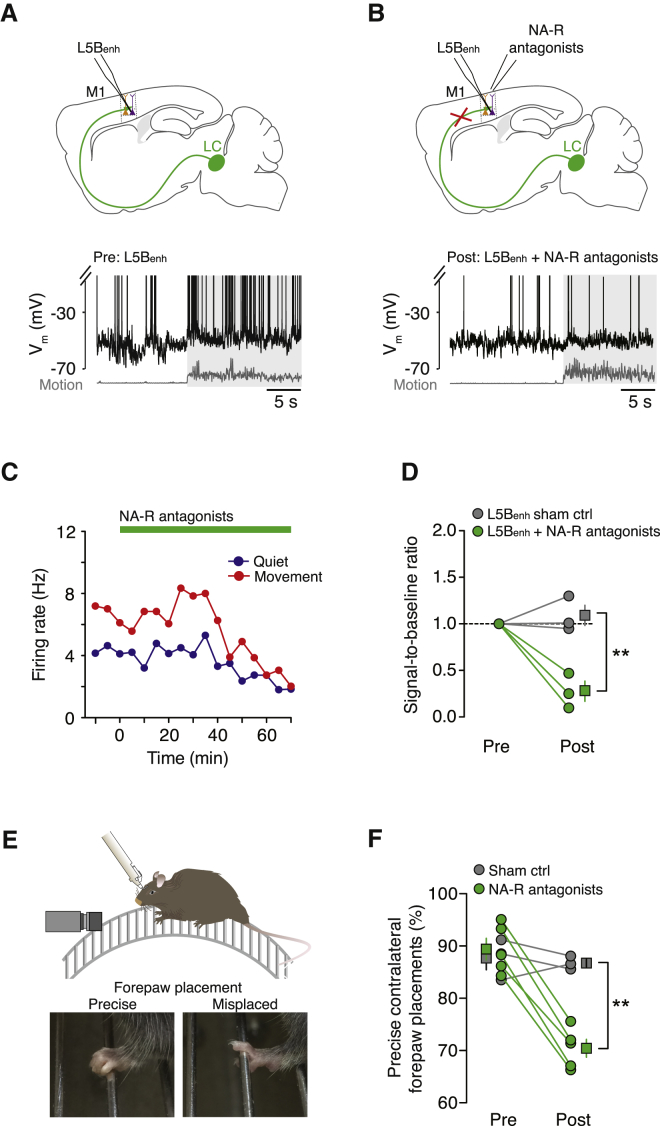
Blocking Noradrenergic Input Reduces the SBR in L5Benh Neurons and Impairs Contralateral Forepaw Motor Coordination(A and B) Schematic representation of the experimental design and representative voltage traces from an L5Benh pyramidal neuron prior to (A) and after (B, >30 min) topical application of noradrenergic receptor antagonists. Gray shading depicts movement.(C) Time course shows quiet (blue) and movement-related (red) firing rates in an L5Benh pyramidal neuron before and after noradrenergic receptor blockade (green bar).(D) Movement-induced SBR in L5Benh pyramidal neurons before and >30 min after application of noradrenergic receptor antagonists (green circles, n = 3) or saline (gray circles, n = 3). Square symbols represent mean ± SEM. Unpaired t test, ∗∗p < 0.01.(E) Behavioral assessment of forepaw placement precision in head-fixed mice mounted on a single-axis, cylindrical runged treadmill. Video sequences were used to score contralateral and ipsilateral forepaw placements.(F) Percentage of precise contralateral forepaw placements before and 60 min after application of noradrenergic receptor antagonists (green circles, n = 5) or saline (gray circles, n = 3). Square symbols represent mean ± SEM. Unpaired t test, ∗∗p < 0.01.See also Figure S6.